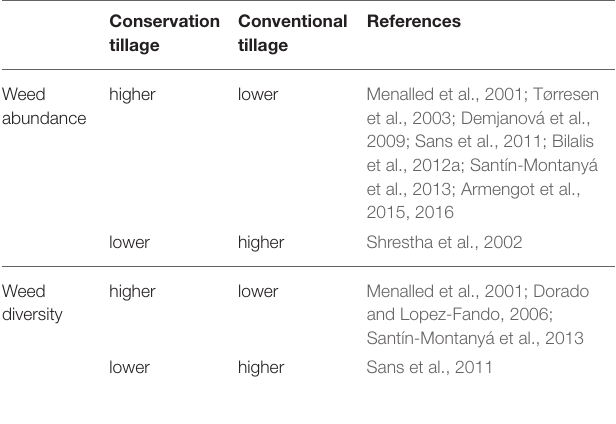
TABLE 2 | Indicative response of conservation and conventional tillage practices on weed abundance and